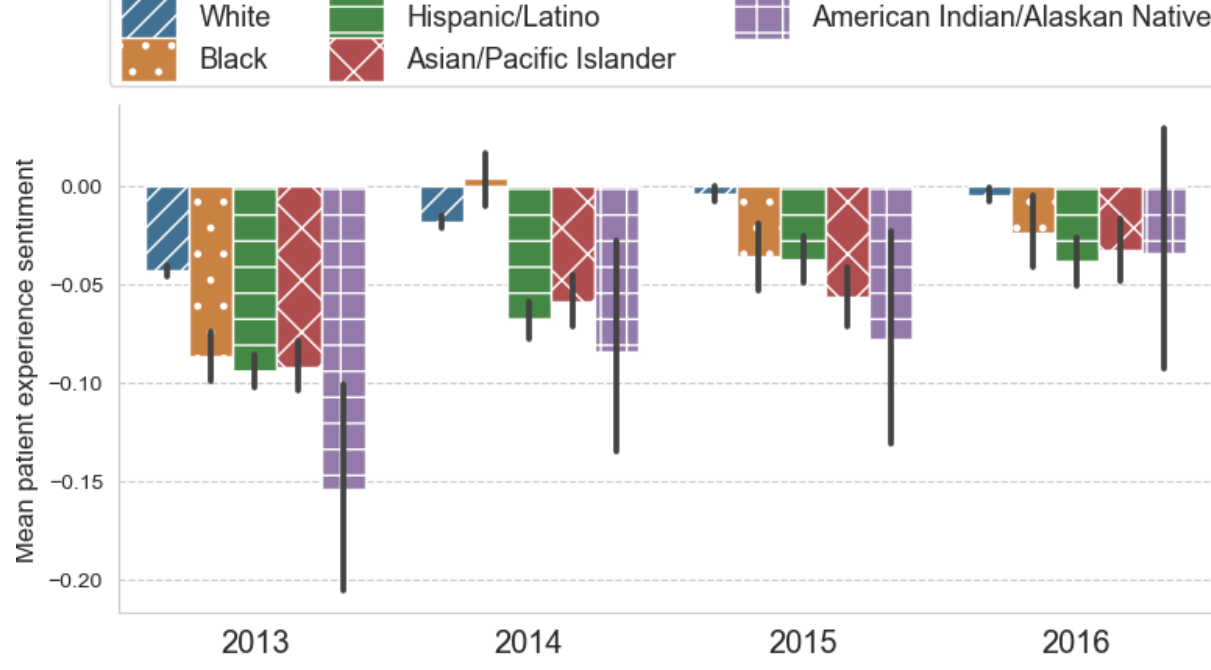
Figure 4. Overall average patient experience sentiment by racial and ethnic group for the years from 2013 to